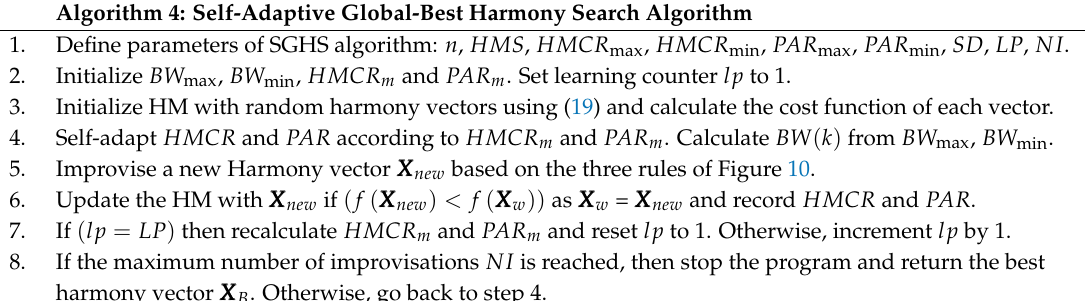
Algorithm 4: Self-Adaptive Global-Best Harmony Search Algorithm